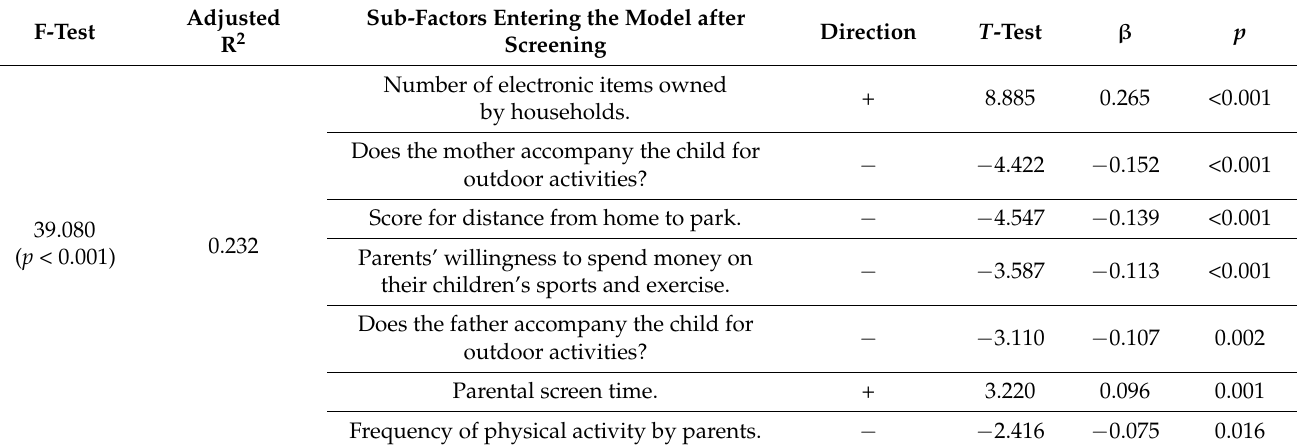
Table 7. Regression model of screen time for school